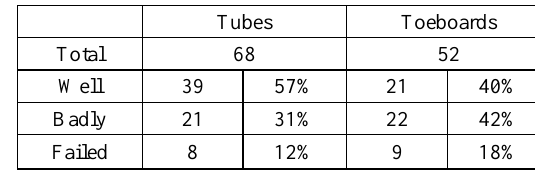
Table2. The statistic of quality of reconstructed